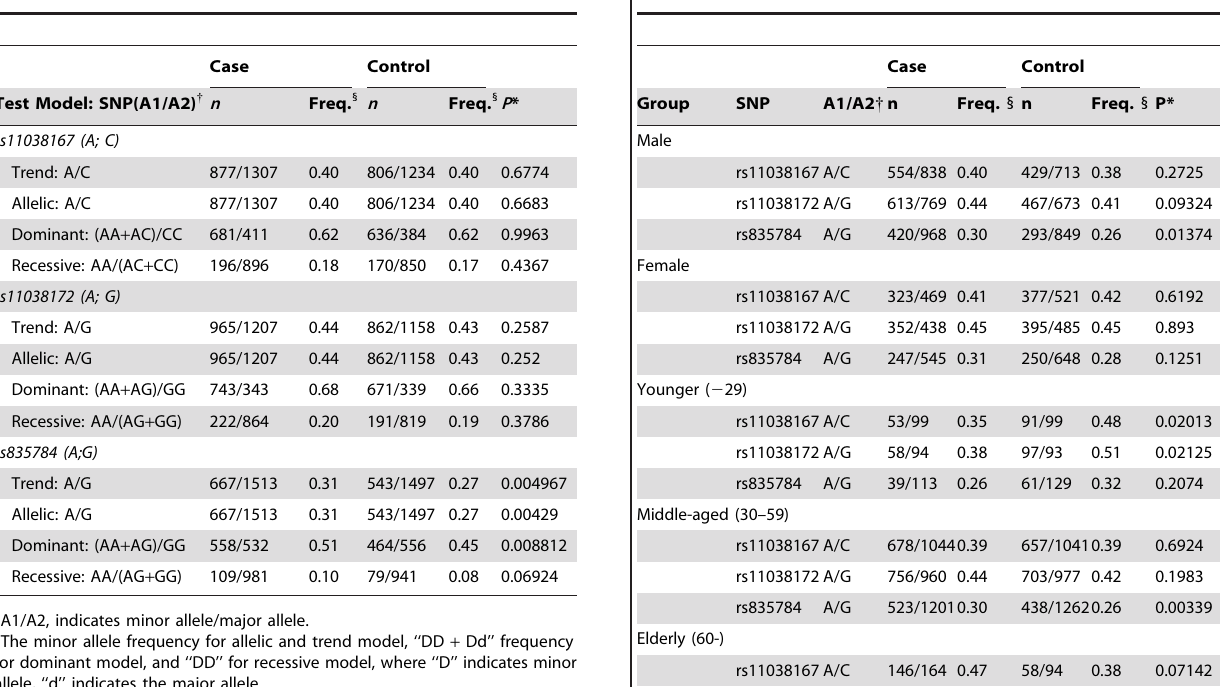
Table 3. llele frequency distribution by sex and age group for three SNPs in